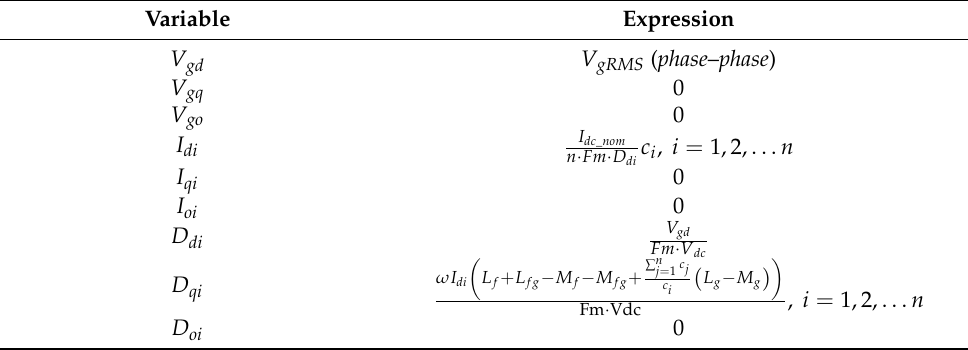
Table 1. Expression of the variables in the operation